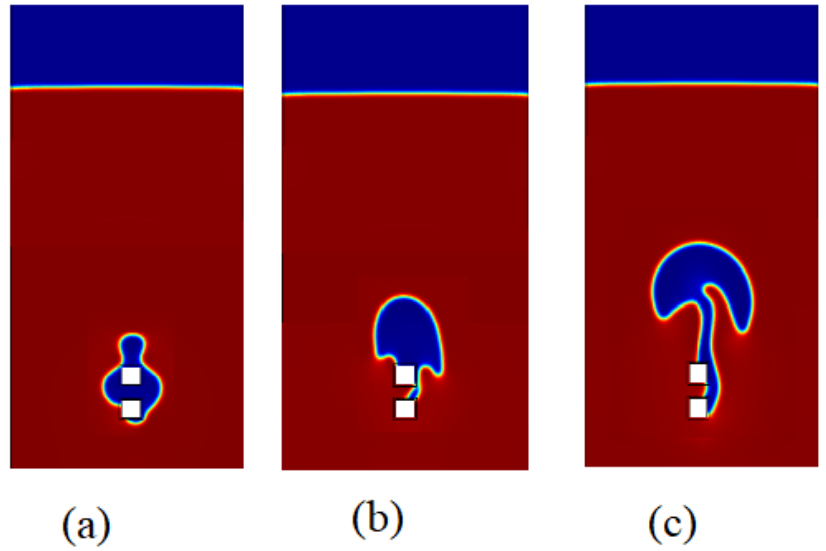
Figure 15. Effect of magnetic field angle on Bubble